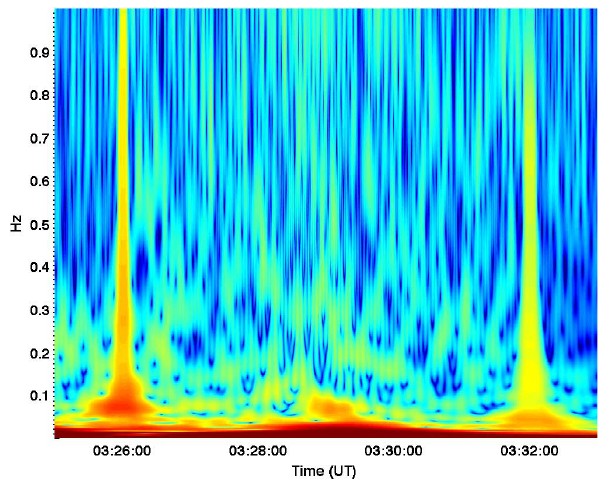
Fig. 5. Low-frequency wave spectrum observed during a passage of the DEMETER satellite in the vicinity of the earthquake epicentre on the day before the